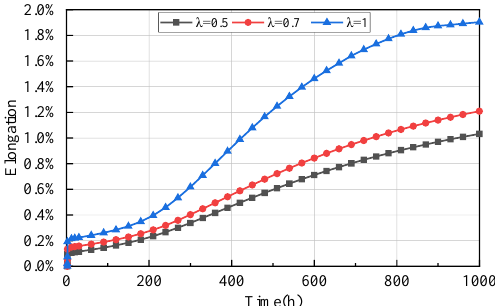
Figure 13. Sensitivity analysis of the elongation of the bolts with respect to the lateral pressure coefficient λ when β = 0.4 and ξ =